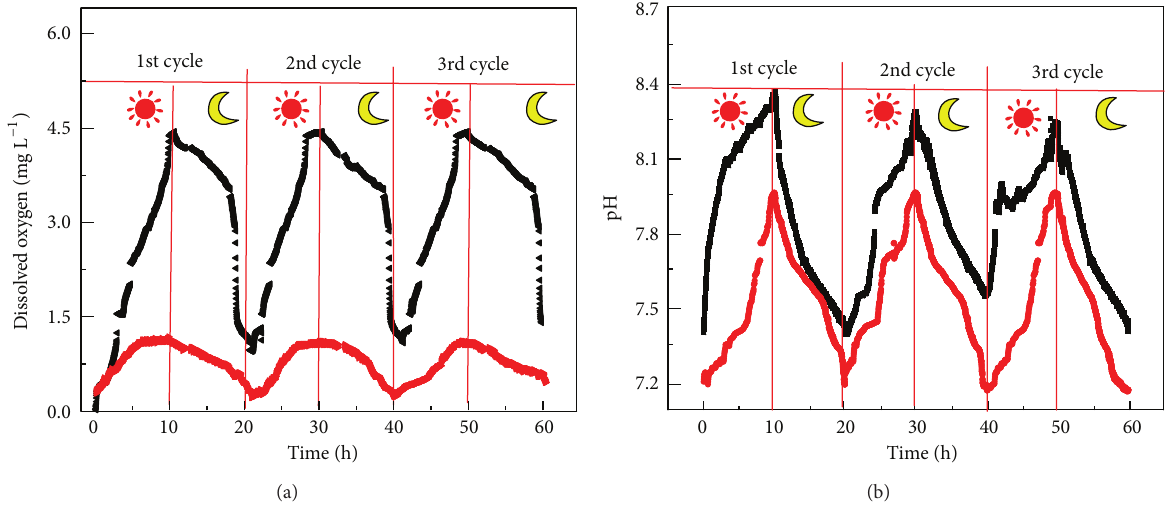
Figure 5: Changes in dissolved oxygen concentration (a) and pH (b) of the cathode electrolyte during illumination and dark circulation. (The symbols of moon and sun represent light and dark conditions, resp.). (Black line: CO 2 was allowed to travel through the tube; red line: CO 2 travel through the silicon tube was